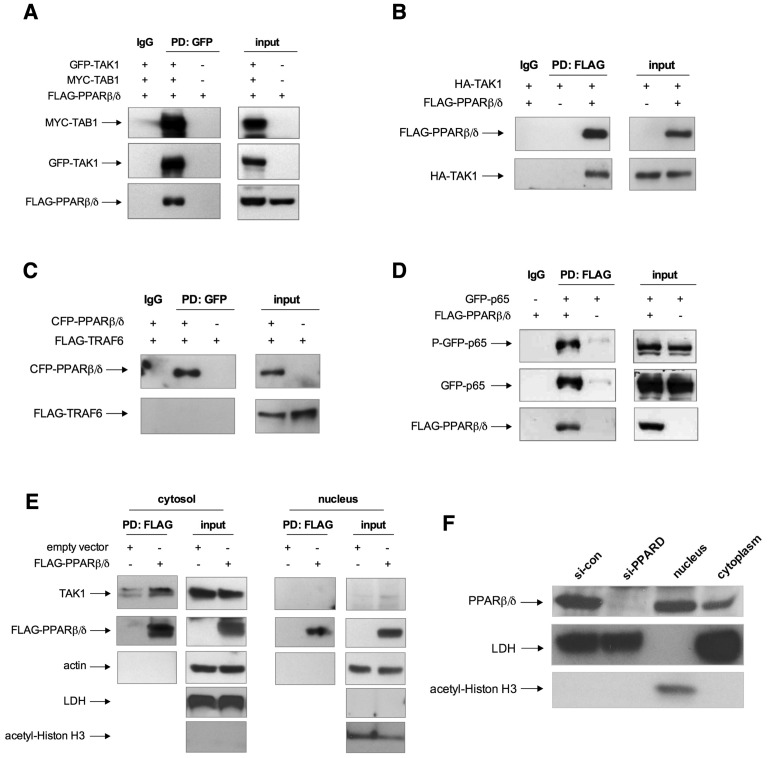
Complex formation of PPARβ/δ with TAK1/TAB1.(A) Co-immunoprecipitation of PPARβ/δ with TAK1 and TAB1. HEK293IL-1R cells were transfected with expression vectors for MYC-tagged TAB1, GFP-tagged TAK1 and FLAG-tagged PPARβ/δ. Pulldown (PD) was carried out with an antibody against GFP, and immunoblotting with antibodies against TAB1, TAK1 or FLAG. Input lanes were loaded with 50 µg protein (3% of the amount used for IPs). (B) Co-immunoprecipitation of PPARβ/δ and TAK1. HEK293IL-1R cells were transfected with expression vectors for HA-tagged TAK1 and/or FLAG-tagged PPARβ/δ. Pulldown (PD) was carried out with an antibody against FLAG, and immunoblotting with antibodies against TAK1 or FLAG. (C) Co-immunoprecipitation of PPARβ/δ and TRAF6. HEK293IL-1R cells were transfected with expression vectors for FLAG-tagged TRAF6 and/or CFP-tagged PPARβ/δ. Pulldown (PD) was carried out with an antibody against GFP, and immunoblotting with antibodies against GFP or TRAF6. (D) Co-immunoprecipitation of PPARβ/δ and p65. HEK293IL-1R cells were transfected with expression vectors for FLAG-tagged PPARβ/δ and/or HA-tagged p65. Pulldown (PD) was carried out with an antibody against FLAG, and immunoblotting with antibodies against FLAG or HA. (E) Cytoplasmic interactions of FLAG-PPARβ/δ with endogenous TAK1. HEK293T cells were transfected with expression vectors for FLAG-tagged PPARβ/δ. Cells were fractionated into cytoplasmic and nuclear fractions, pulldown (PD) was carried out with an antibody against FLAG, and immunoblotting with antibodies against TAK1, FLAG and actin. (F) Subcellular localization of endogenous PPARβ/δ in HEK293T cells. Cytoplasmic and nuclear fractions were isolated and analyzed by immunoblotting with an antibody against PPARβ/δ. Antibodies against lactate dehydrogenase (LDH) and acetyl-Histon H3 were included in panels E and F to control for the purity of the cytoplasmic and nuclear fractions.